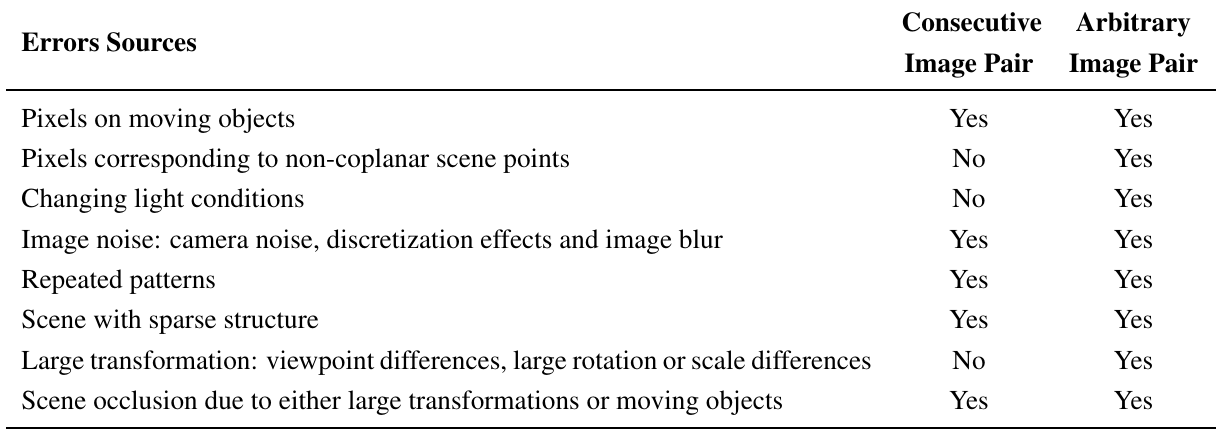
Table 1. Error sources in the image registration of our